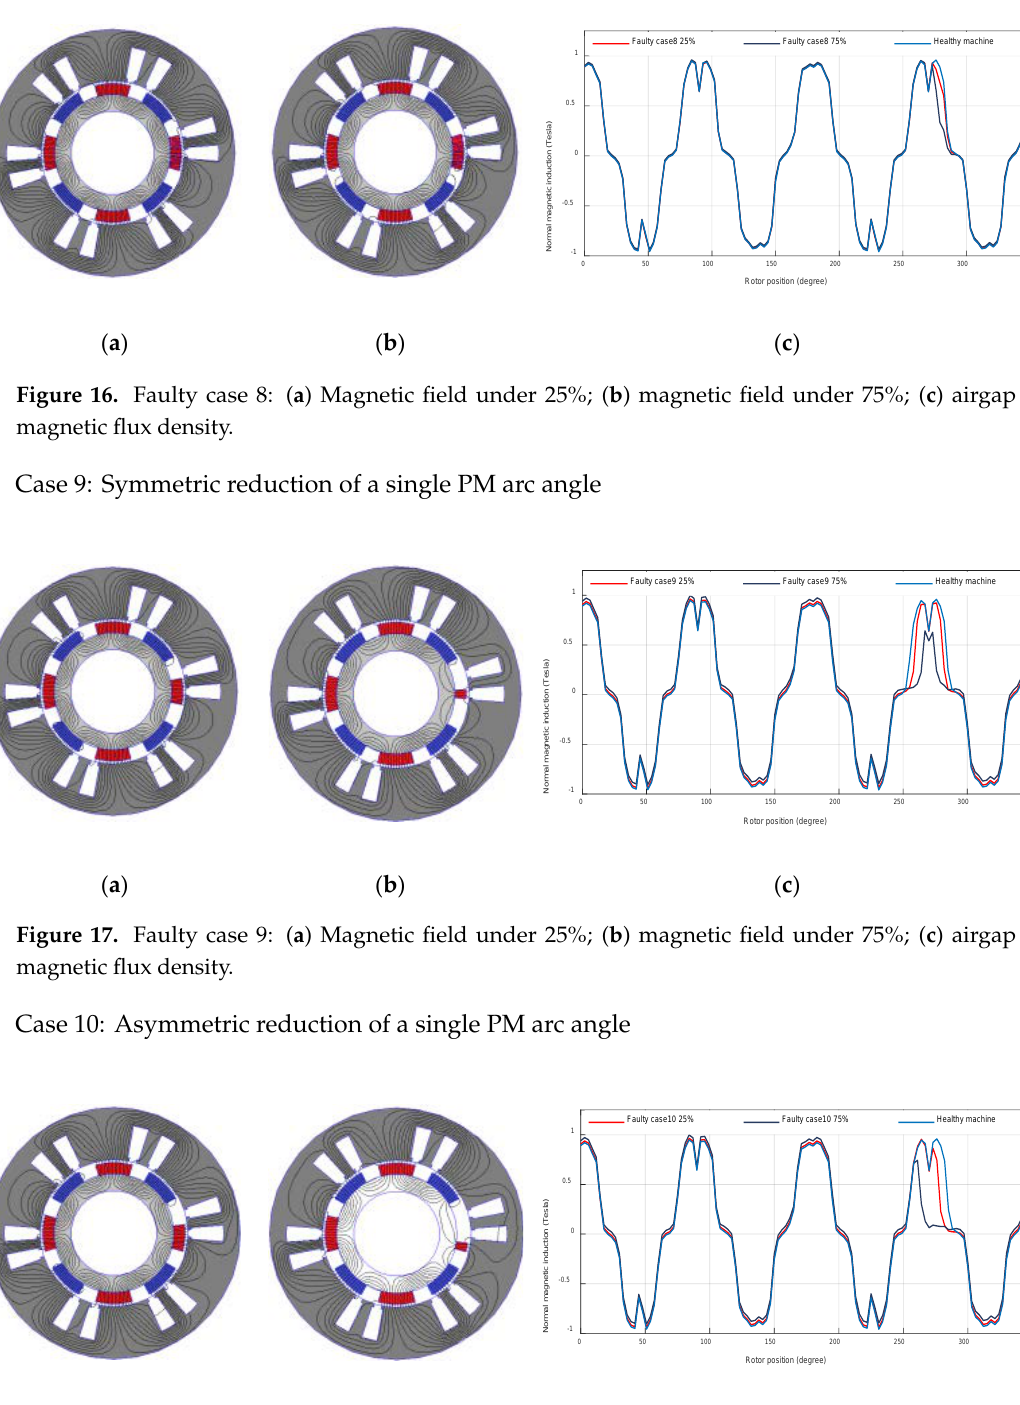
Figure 18. Faulty case 10: ( a ) Magnetic field under 25%; ( b ) magnetic field under 75%; ( c ) airgap magnetic flux density.